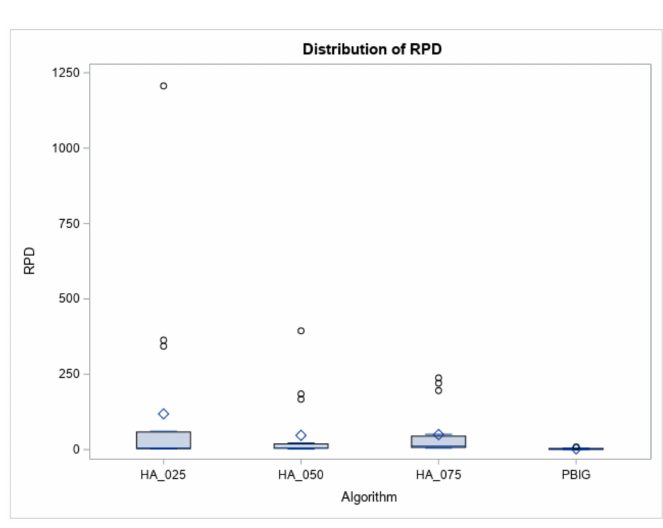
Figure 9. The distribution of the AEP.